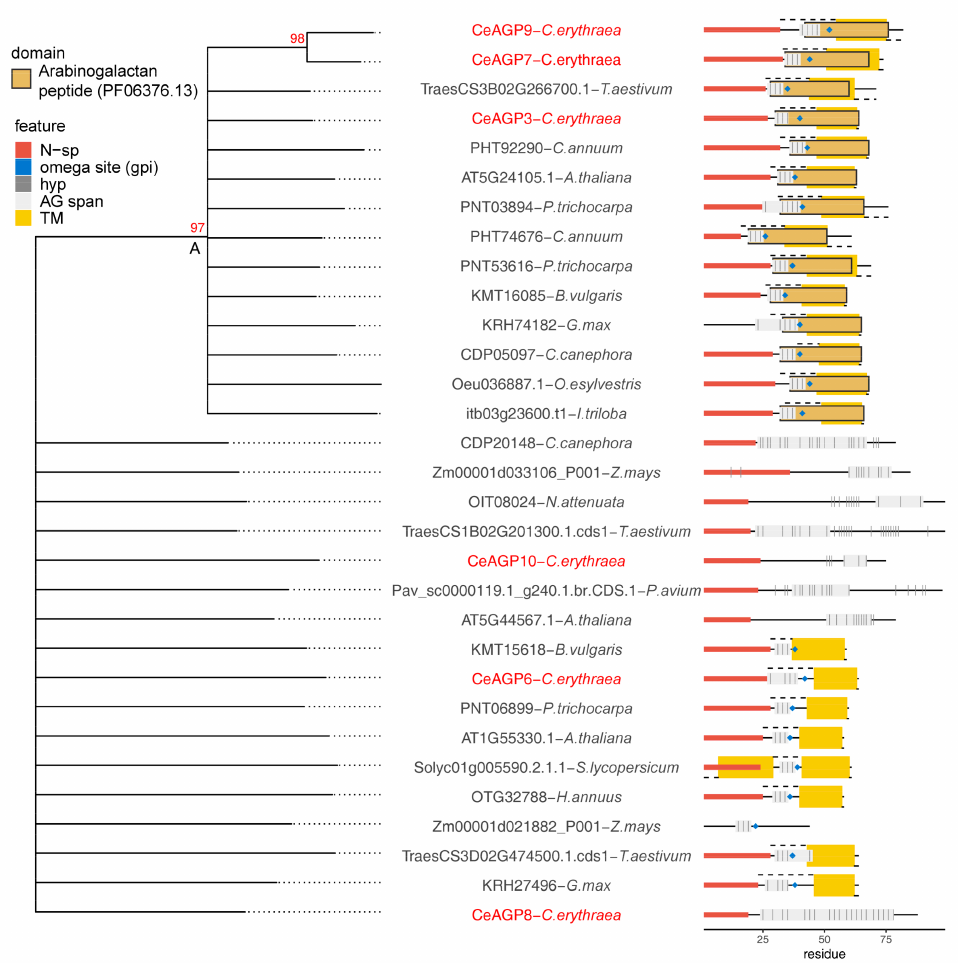
Figure 5. Phylogenetic relationship of six C. erythraea AGp protein sequences with homologues from other plant species. The phylogenetic tree represents an unrooted neighbor joining tree constructed based on an alignment-free distance matrix (3-mer count as implemented in kmer R package). Cluster stability was evaluated using 100 replicates of nonparametric bootstrap. Clusters with ≥ 80/100 bootstrap support are indicated with a red number. Clusters with ≤ 50/100 bootstrap support were collapsed into multichotomies. Protein schematic diagram was constructed using ragp R package: N-sp as predicted by Signalp4.1 are represented with red segments on the N-terminus; GPI addition sites (omega sites) as predicted using NetGPI1.1 are represented with blue diamonds; domains as predicted with hmmscan 3.3.2 and using Pfam-A33 database are represented according to the color legend; trans-membrane domains (TM) as predicted using Phobius1.01 are represented using yellow rectangles; proteins with predicted TM extracellular regions are indicated with dashed lines above the sequence diagrams, while intracellular regions are indicated with dashed lines below the sequence diagrams; hydroxyprolines as predicted with ragp 0.32 are indicated with bar-code-like vertical black lines, while AG motif spans (at least three AG motifs, no more than 10 amino acids apart) are indicated with light grey